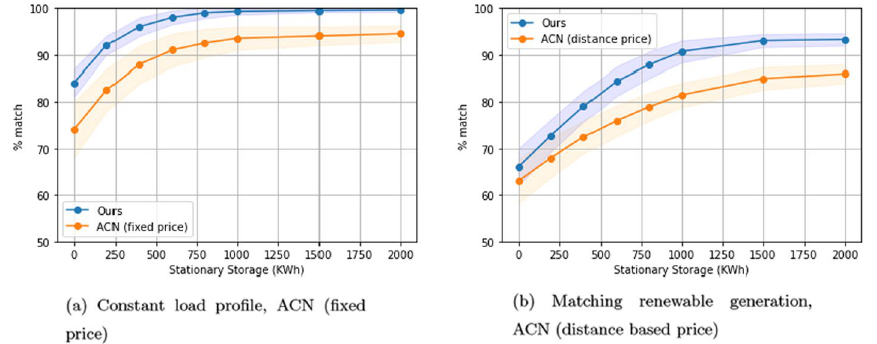
Fig. 7 Comparison of our solution to ACN over different levels of stationary storage. One-way charging in a residential setting